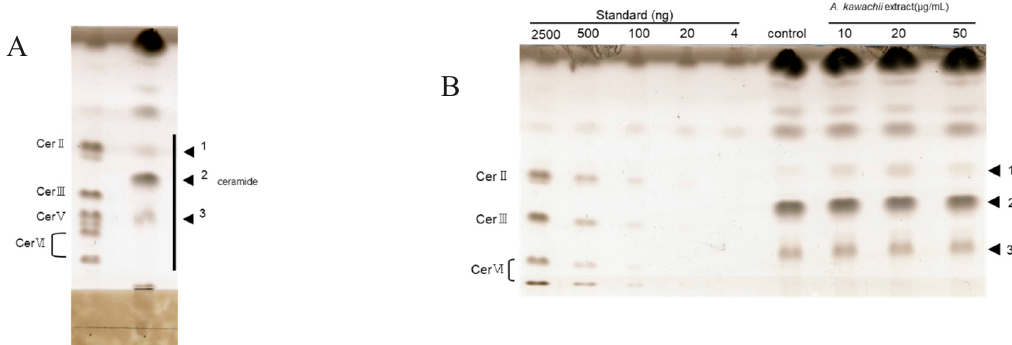
Figure 5. Increase of ceramide in NHEK cells upon the addition of koji lipid extract. ( A ) Total lipids were extracted from NHEK cells which had been incubated for 24 h with 10, 20, or 50 µ g / mL of lipids (dissolved in 0.5% DMSO) extracted from white koji . ( B ) The lipid constituents were analysed with HPTLC, developed using a chloroform–methanol–acetic acid solvent (190:9:1, v / v ). Band 1 corresponds to ceramide II (NS), and band 3 corresponds to ceramide V.